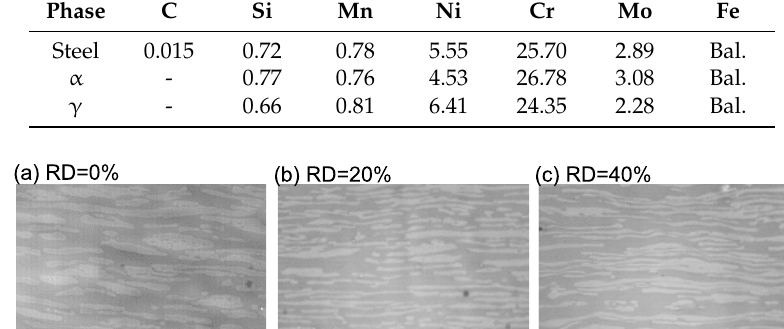
Table 2. Chemical composition of SUS329J4L steel and its constituent phases (wt. %).